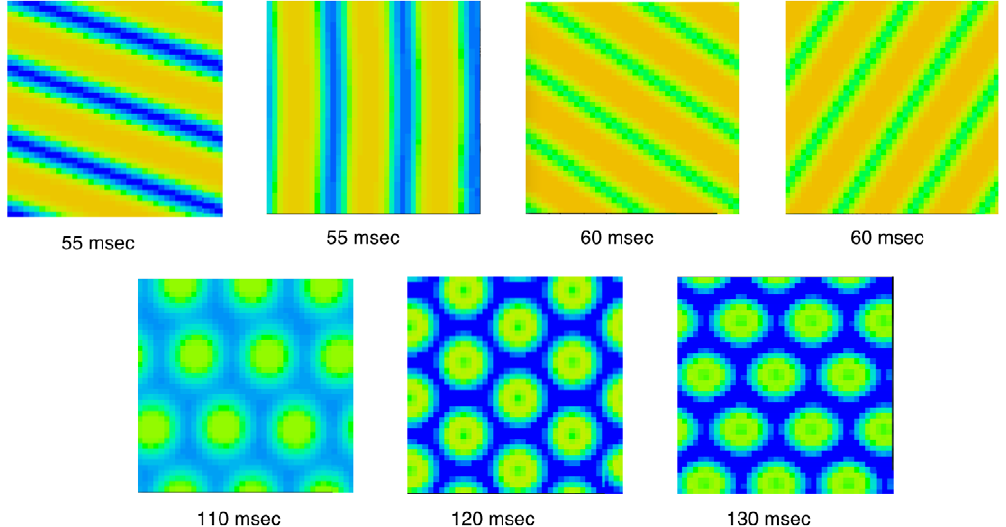
Figure 4. Sample two-dimensional patterns seen in a 40 | 40 grid with periodic boundary conditions. Top row shows patterns seen with high frequency stimuli. Pairs show the results of different random initial conditions. Bottom row shows patterns seen at lower frequency; each pattern has the same period as the stimulus.